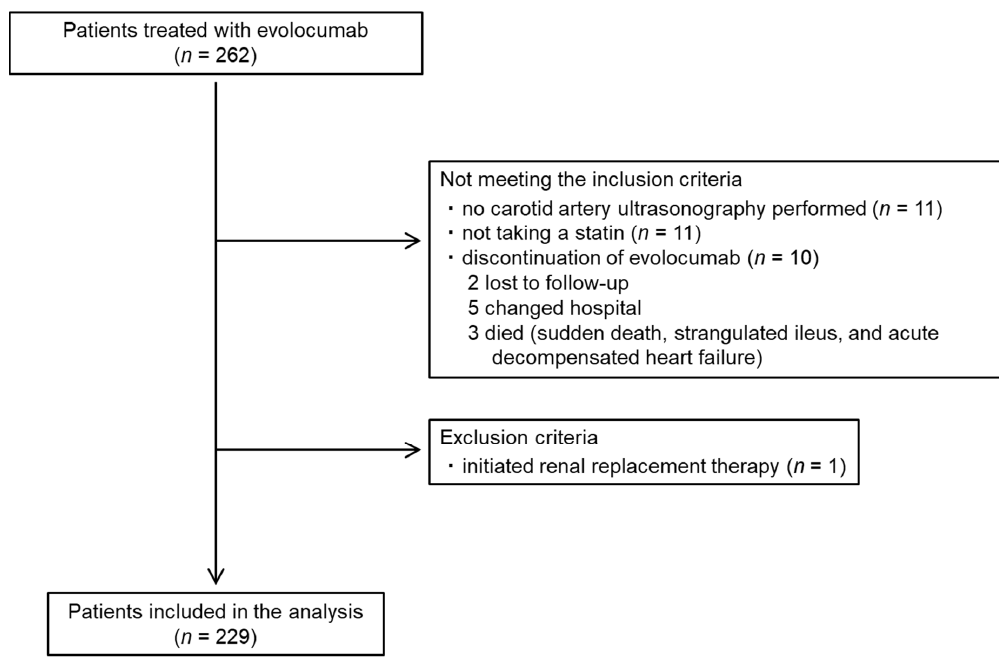
Figure 3. Participant flow diagram. Table 2. Dose of each statin administered.